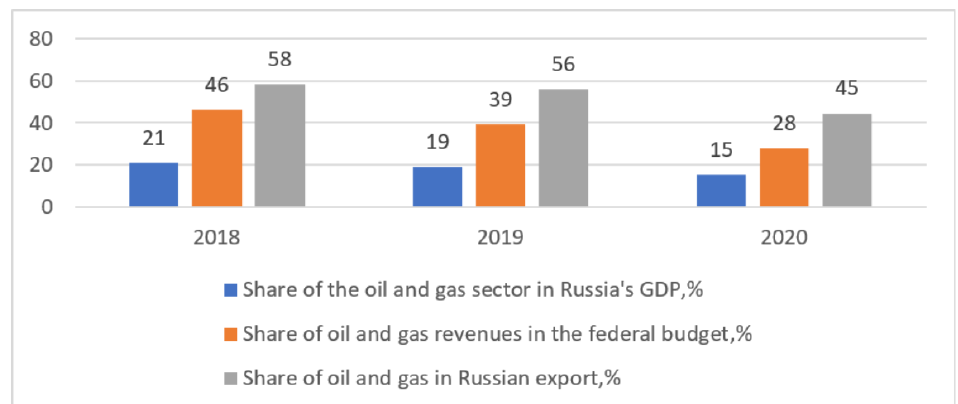
Figure 3. Contribution of the oil and gas industry to the Russian economy [62].